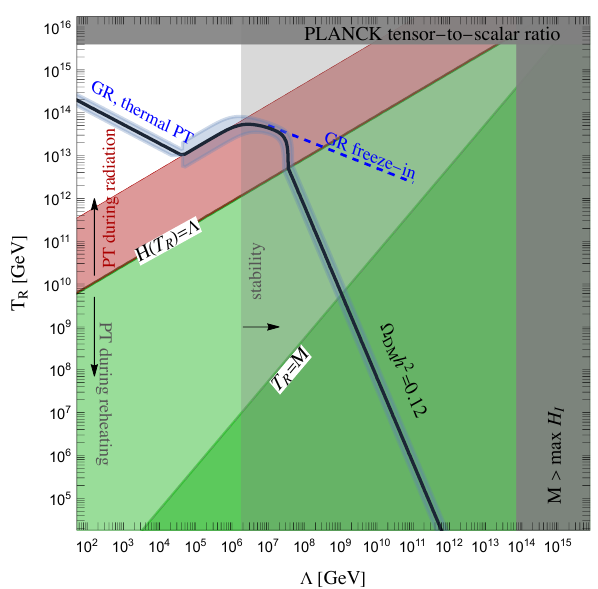
Figure 3 . Parameter space of Glueball DM. The DM abundance is reproduced along the black solid line. The darker green region corresponds to T where the gravitational freeze- R ≤ M 0 ++ in (blue line) becomes inefficient (see eq. (2.1)). The lighter green region corresponds to H R ≤ Λ where the phase transition happens during reheating. The red region is highlighted to show where the contribution from the phase transition generated in radiation domination dominates over the gravitational freeze-in. The light shaded region corresponds to a cosmologically unstable DM according to naive dimensional analysis